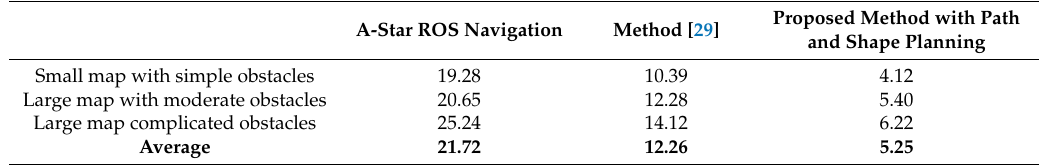
Table 2. The revisited areas ratio comparisons